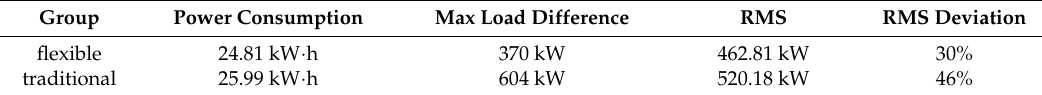
Figure 9. The total power consumption comparison of ADN flexible loads in the underpowered condition; ( a ) flexible group; ( b ) traditional group. Table 6. The comparison of power consumption under power shortage condition.